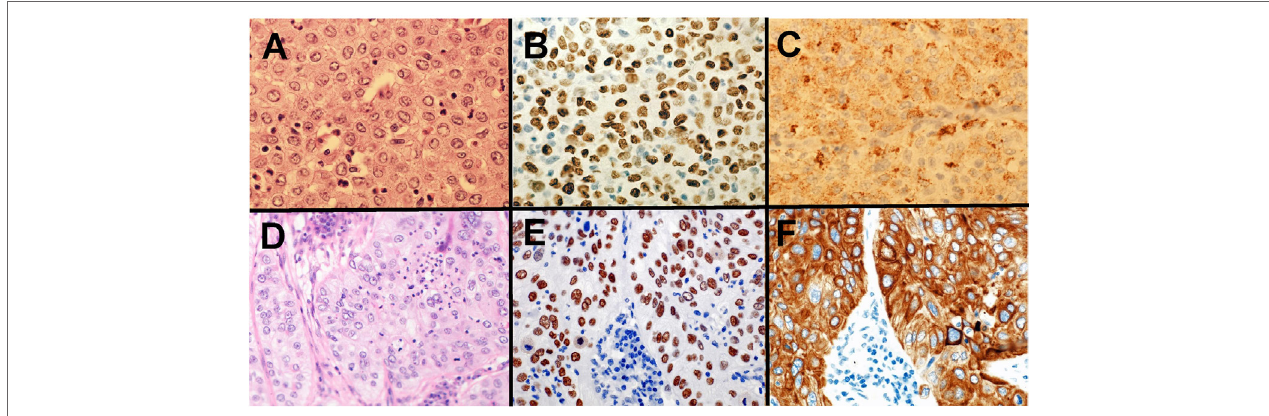
FigURe 1 | Solid adenocarcinoma (A–C) and non-keratinizing squamous cell carcinoma (SqCC) (D–F) . Solid adenocarcinoma [ (A) HE staining] is immunohistochemically positive for TTF-1 (b) and Napsin A (C) . Non-keratinizing SqCC [ (D) HE staining] is immunohistochemically positive for p40 (e) and CK5/6 (F)